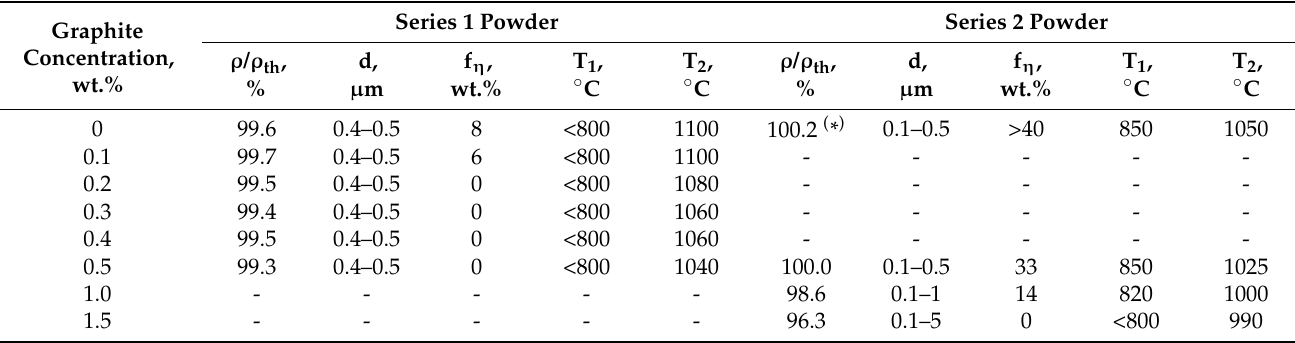
Table 2. Impact of carbon concentration on density, ρ / ρ th ; average grain size, d; and optimal temperatures of solid-phase sintering of WC-10Co